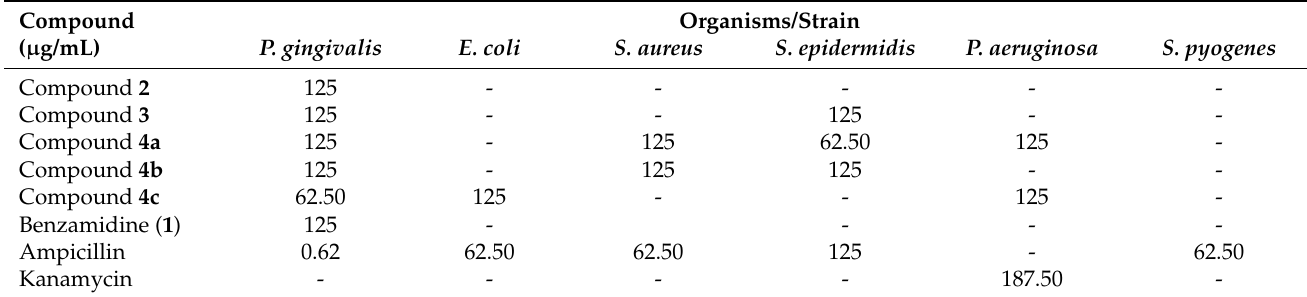
Table 2. MBC values for